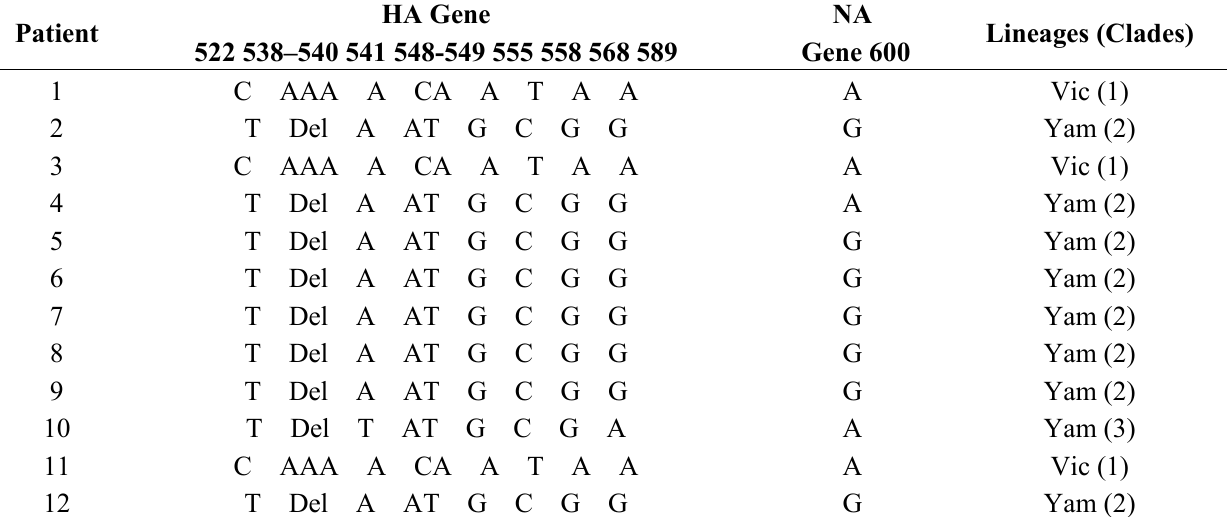
Table 1. Influenza B lineages and clades in Tuscany during the seasons 2012–2013 and